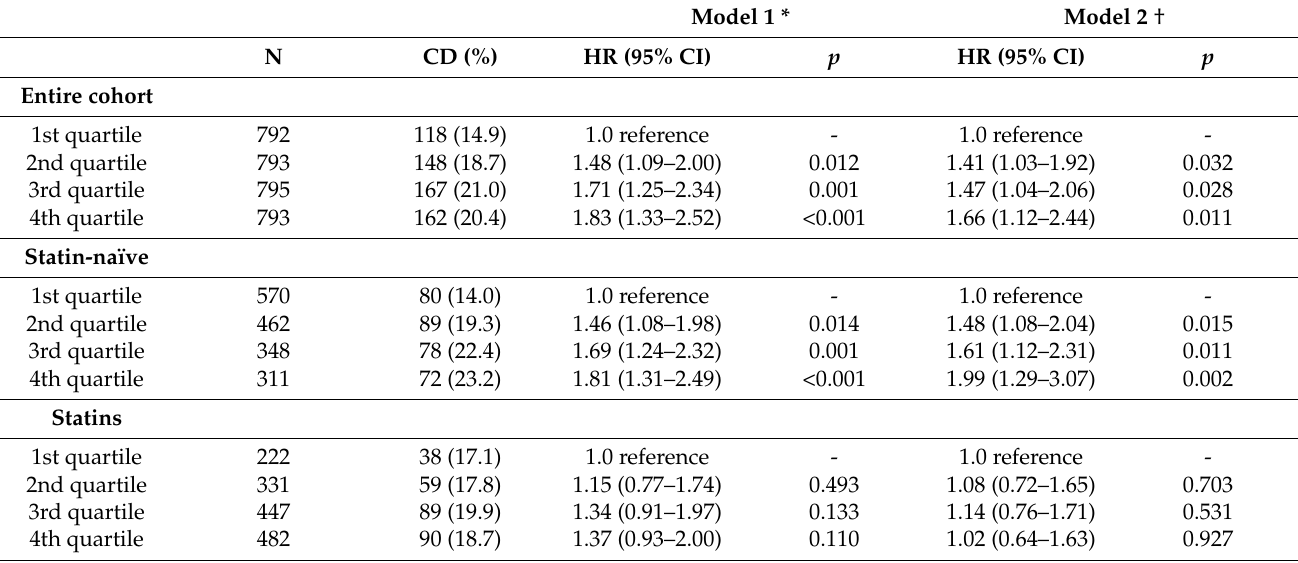
Table 3. Cardiovascular mortality according to LDLapoB/LDLC calc quartiles in the LURIC cohort. Model 1